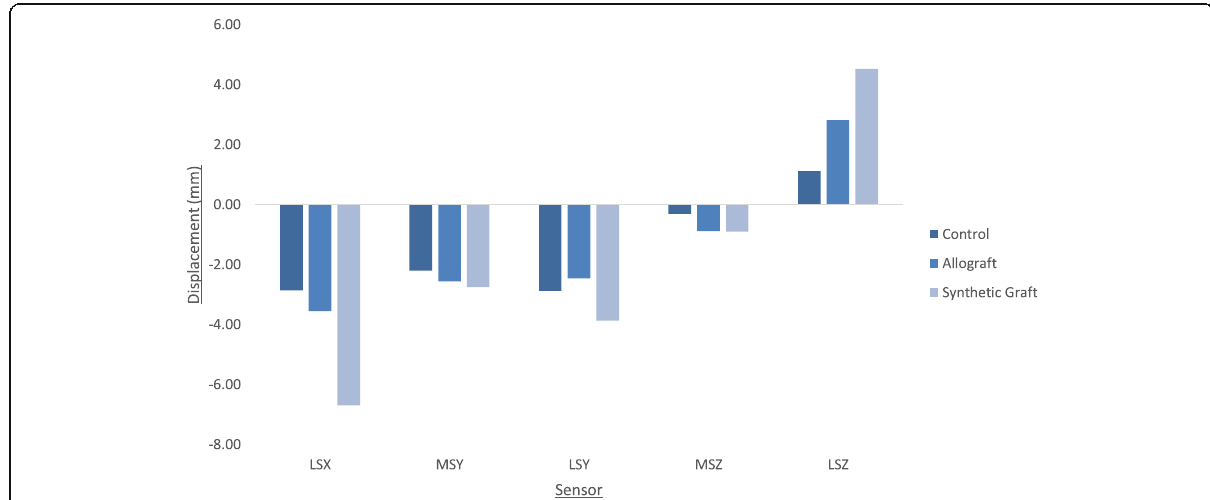
Fig. 4 Mean displacement (mm) at each sensor position around the tibial head. Negative LSX values indicate latero-medial movement; negative MSY and LSY values indicate a posteroanterior movement; negative MSZ values indicate upward vertical movement; positive LSZ values indicate downward vertical movement. Allograft Group ( n = 4), Synthetic Group ( n = 4), Control Group ( n = 5)